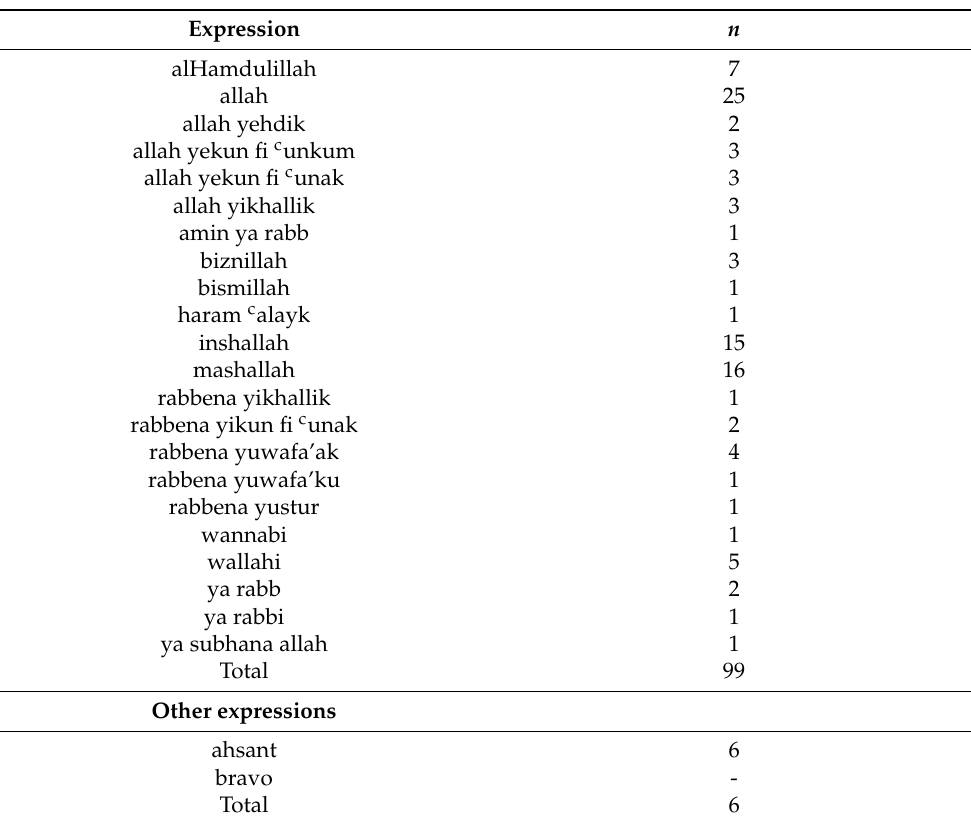
Table 7. Presenter